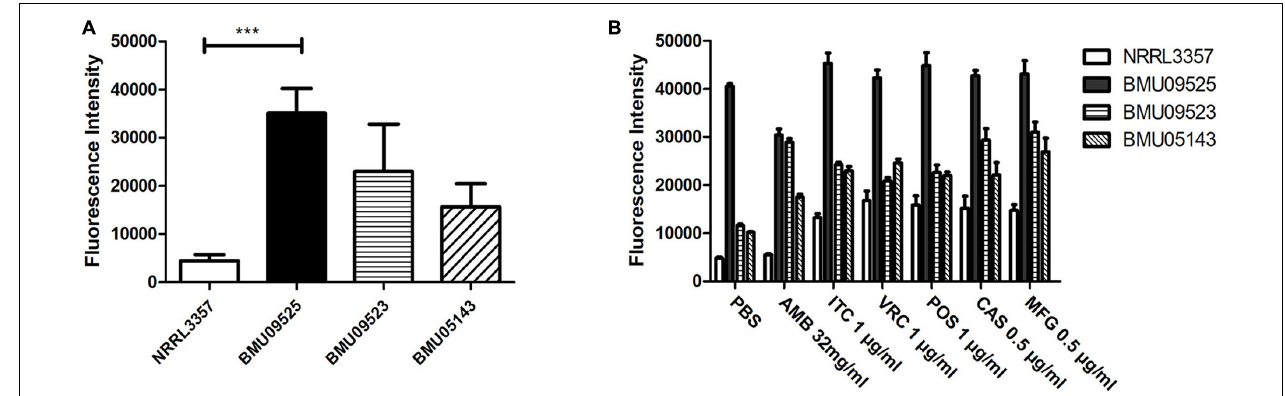
FIGURE 3 | Level of endogenous ROS determined by DCF-DA assay. (A) The level of basal endogenous ROS. (B) The level of endogenous ROS induced by antifungals. Conidial were incubated at 37 ◦ C for 18 h before stained with 10 µ M DCF-DA for 30 min at 37 ◦ C in the dark. After a wash step, different antifungal drugs prepared in PBS were added to the cells. The fluorescence intensity peak was observed after 2 h of incubation with drugs.